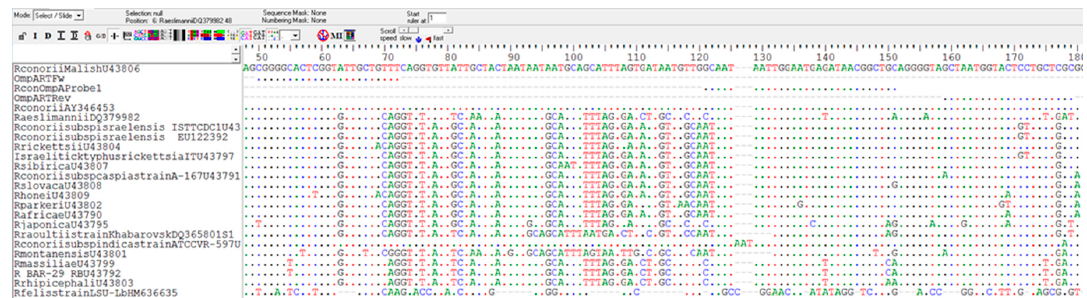
Figure 3. Region of the ompA gene in which the primers and the probe for the RT-PCR specific for R. conorii have been designed. The sequence of R. conorii in this region differs from that of other Rickettsia species.